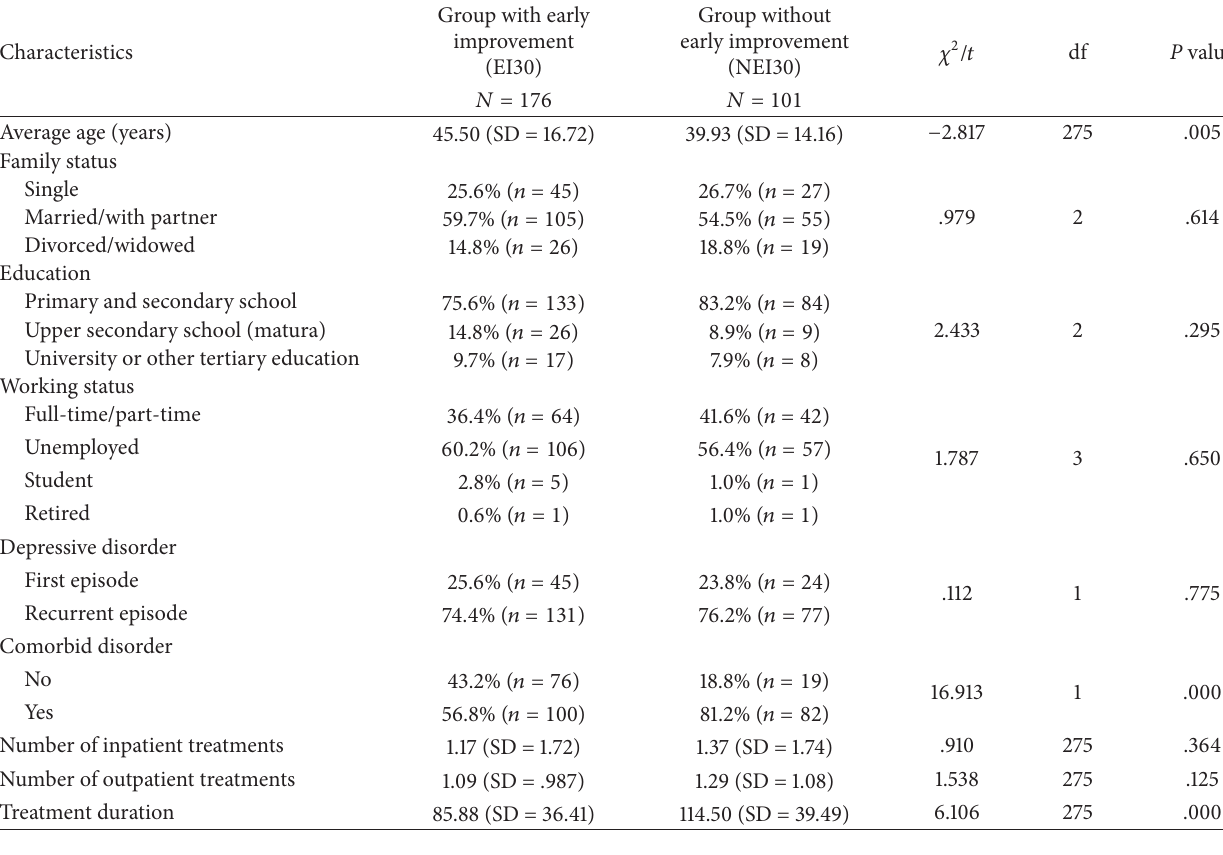
Table 3: Demographic and clinical characteristics of subjects by study groups.